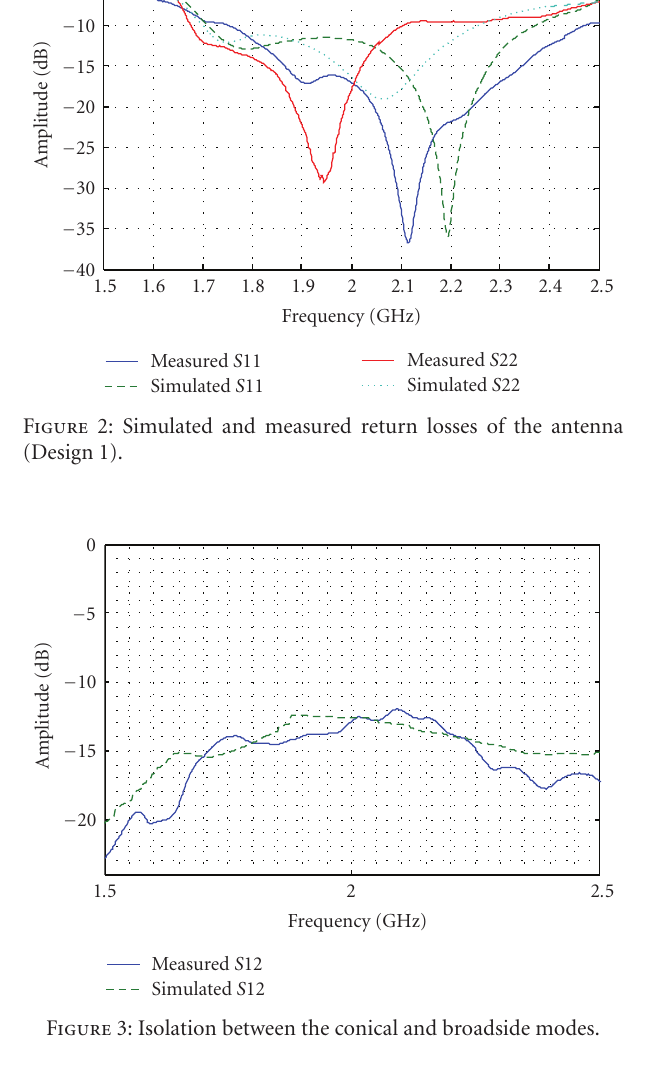
that of the simulated ones by about 100 MHz. The measured S 22 is also 10 dB lower than the one simulated. This variation